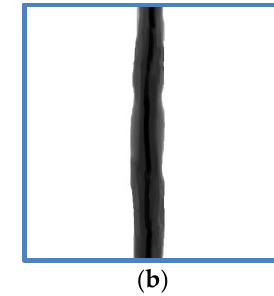
Figure 1. Simulated structures of dimensions 800 nm × 800 nm: ( a ) branched fiber; ( b ) single fiber. The simulated hysteresis loops shown here were superposed of 7 hysteresis loops each,